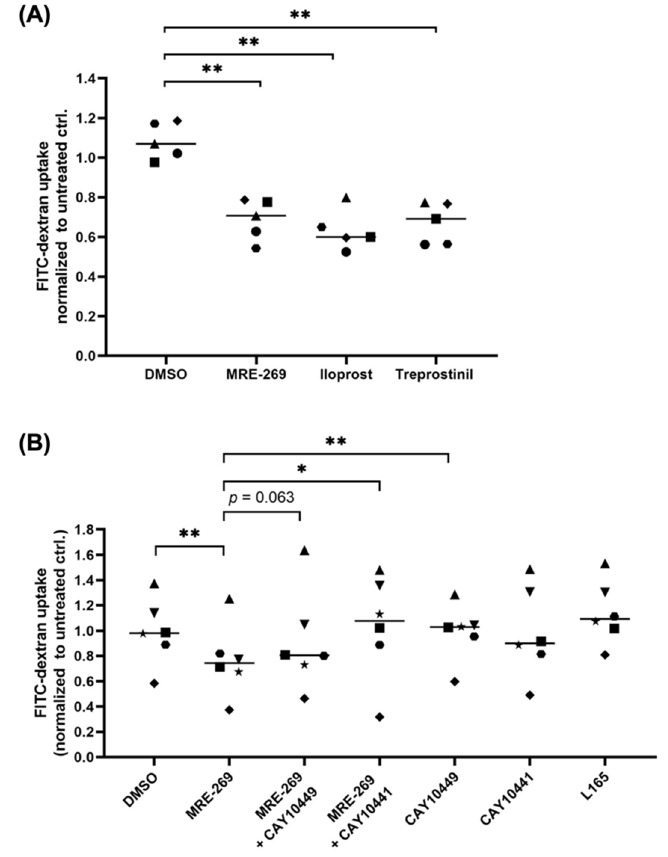
Figure 6. Influence of PGI 2 analogs on macropinocytotic activity of asc-MDM. ( A ) Macropinocytosis was determined by FITC-dextran uptake by asc-MDM after stimulation with 100 nM MRE-269, iloprost or trepostinil or DMSO (solvent control) for 30 min (n = 5; donors are distinguished by different symbols). Results were normalized to untreated controls. ( B ) Macropinocytosis of asc-MDM treated with 1 µM PTGIR antagonist (CAY10449 or CAY10441) prior to stimulation with MRE-269 or DMSO. To test for a role of PPAR β / δ in inhibiting macropinocytosis, asc-MDM were stimulated with 1 µ M L165041. * p < 0.05, ** p < 0.01 by paired t test. Horizontal bars show the